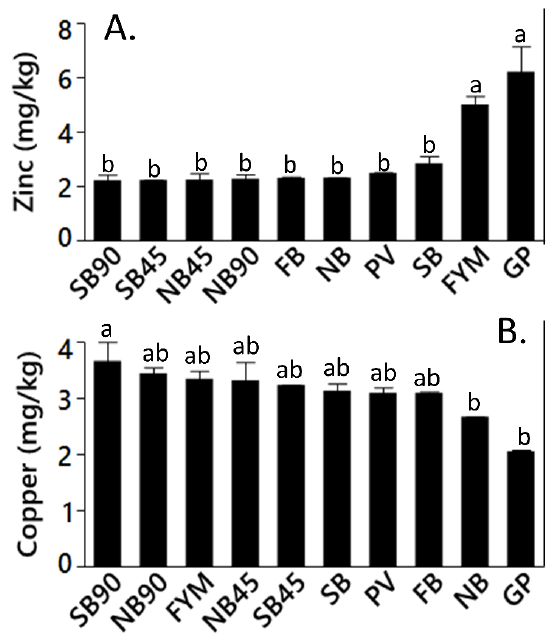
Figure 3. Mehlich III extractable zinc ( A ) and copper ( B ) dynamics in upper 10-cm soil surface after 84 years of Crop Residue Long-term Experiment (CR-LTE) in Adams, OR. NB = No burn, SB = spring burn, FB = fall burn, GP = grass pasture, FYM = farmyard manure, and PV = pea vine. 0, 45, 90 accompanied by NB, SB, and FB represents rates of N applied at 0 kg ha − 1 , 45 kg ha − 1 , and 90 kg ha − 1 , respectively. Means sharing the same letter are not significantly different ( p > 0.05).